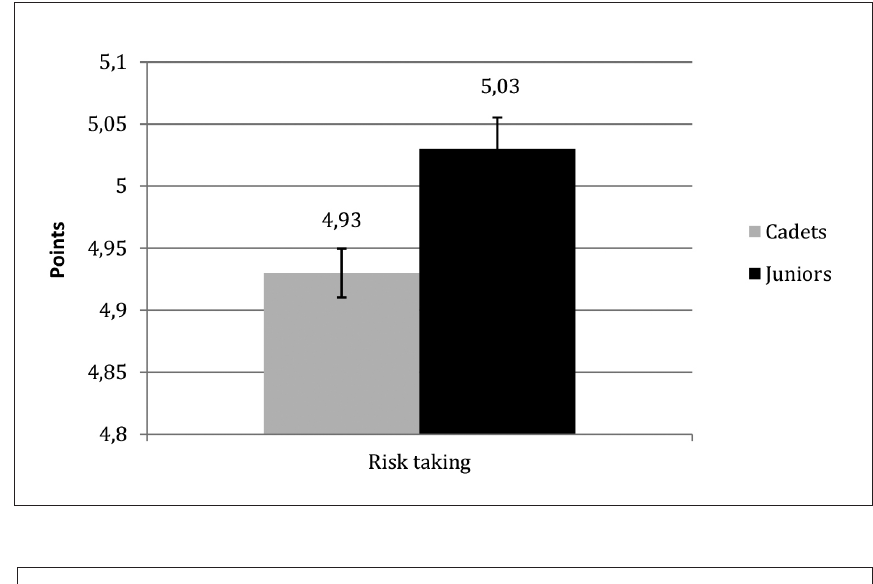
Figure 1. Mean scores in risk